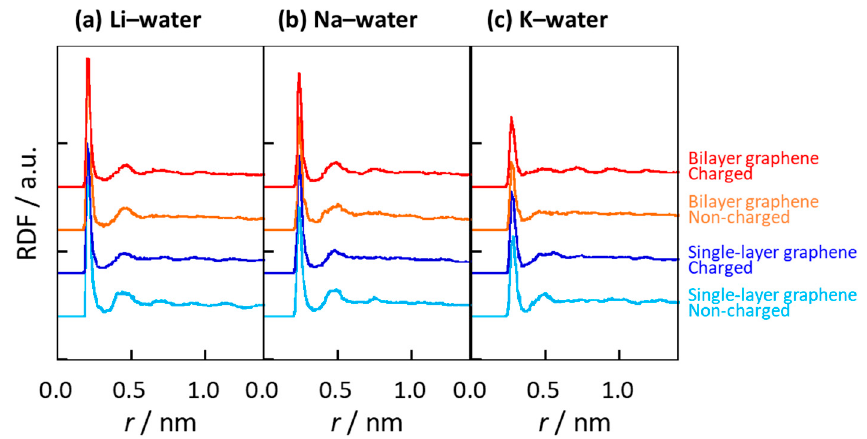
Figure 9. Radial distribution functions between ( a ) Li ion and water, ( b ) Na ion and water, and ( c ) K ion and water during charging and discharging. Charging and non-charging cycles for single-layer graphene are illustrated by dark and light blue, respectively. Charging and non-charging cycles for bilayer graphene are illustrated in red and orange, respectively.